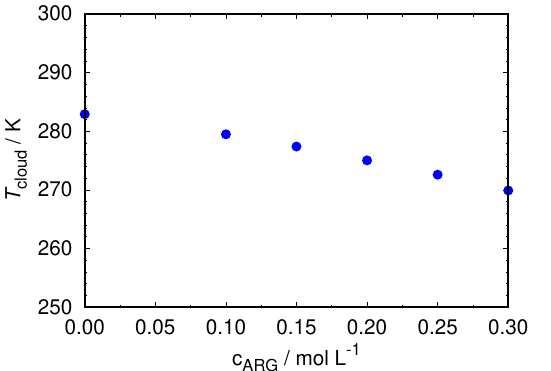
Figure 1. Measured T cloud of 90 mg mL − 1 HEWL in 0.1 M ACES containing 0.25 M NaBr at different concentrations of free